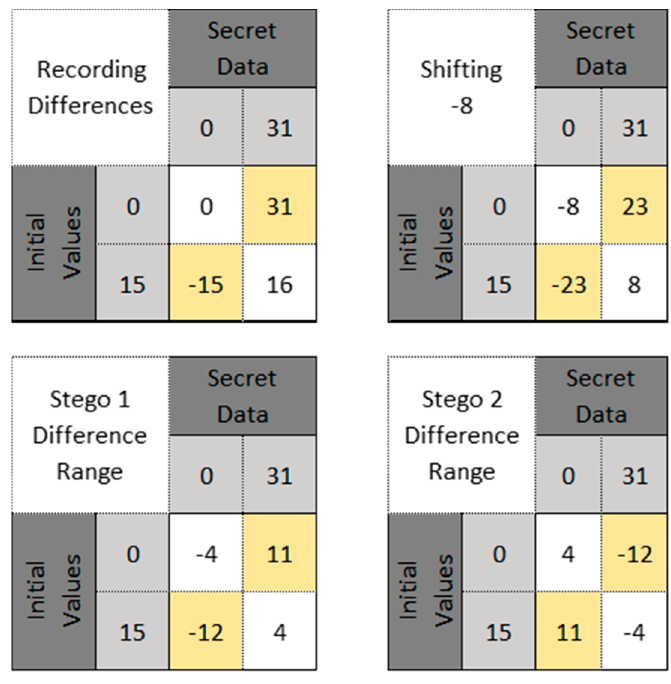
Figure 4. The state of change interval for n = 4.